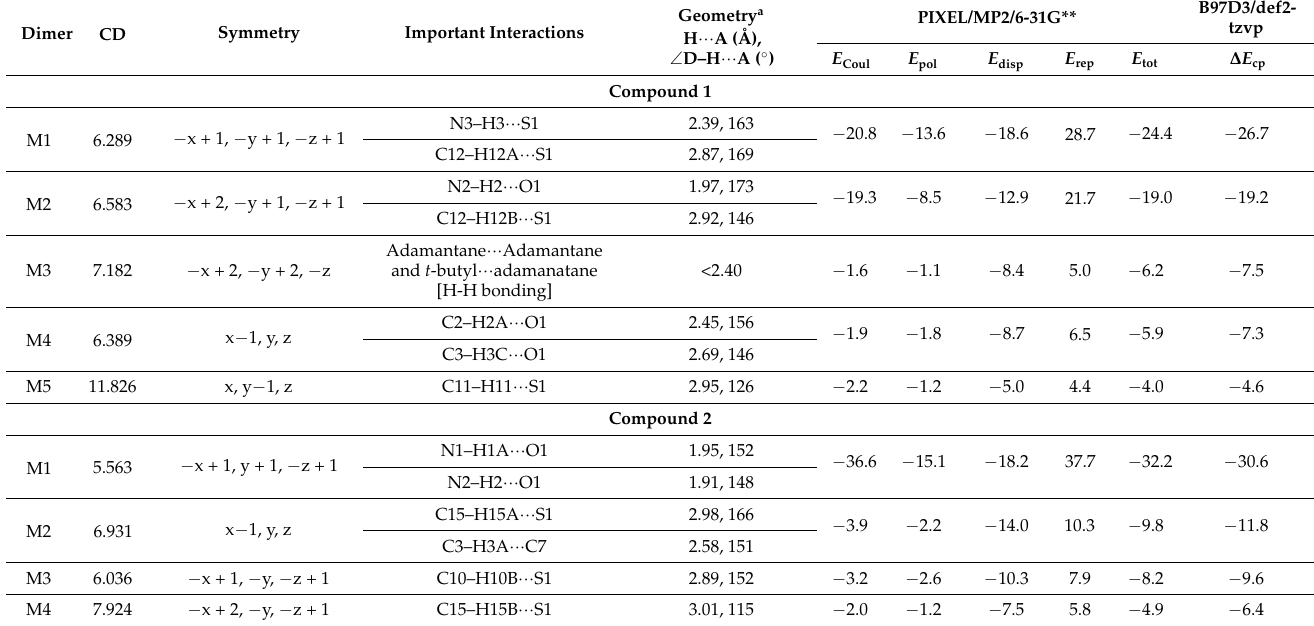
Table 3. Intermolecular interaction energies (in kcal mol − 1 ) for different dimers were obtained from the crystal structures of 1 and 2 by using the CLP-PIXEL method. The BSSE-corrected dimerization energies calculated by the DFT method were given for